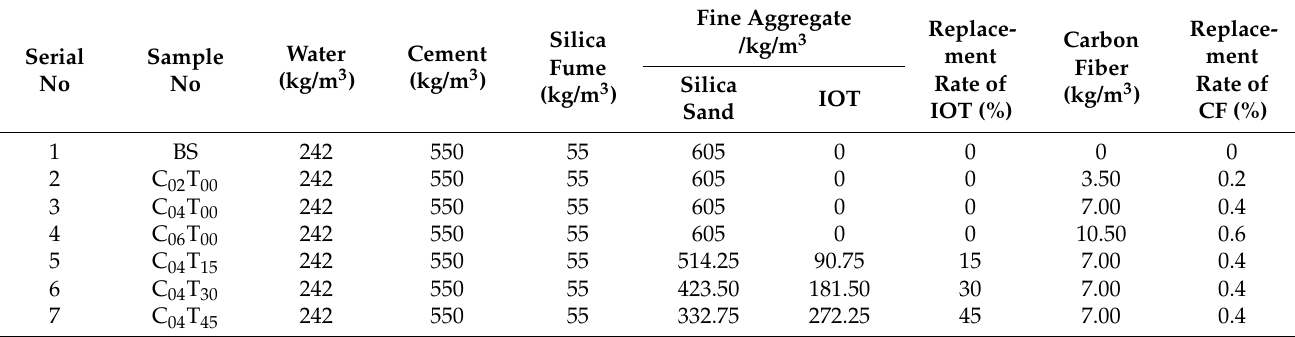
Table 5. The mix design of cement-based piezoelectric composites.